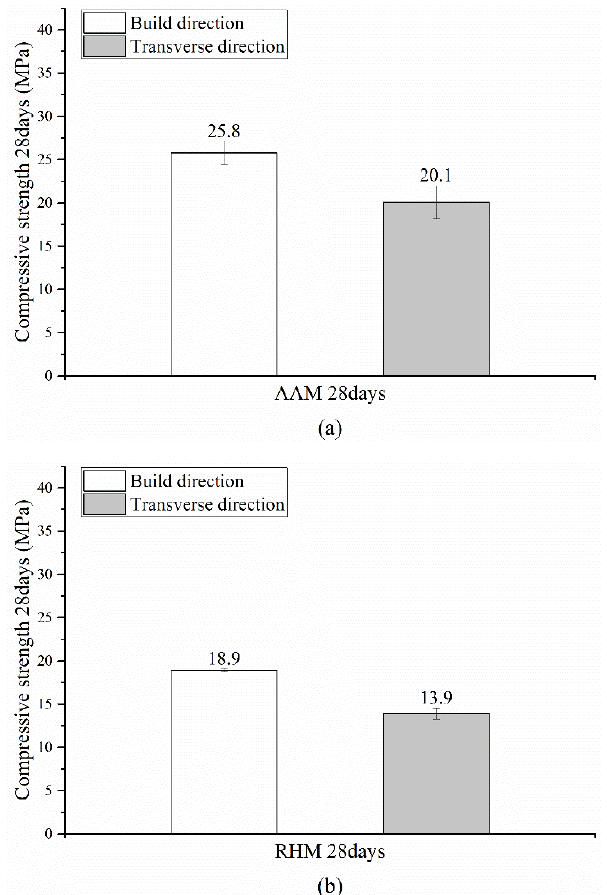
Figure 6. Compressive strength test results with respect to the build orientation: ( a ) alkali-activated mortar (AAM) and ( b ) rapid hardening mortar (RHM).